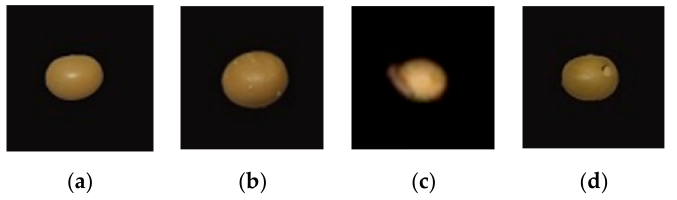
Figure 2. Hyperspectral image of soybean samples (( a ). Normal soybean; ( b ). Soybean with egg; ( c ). Soybean with larvae; ( d ). Gnawed soybean).